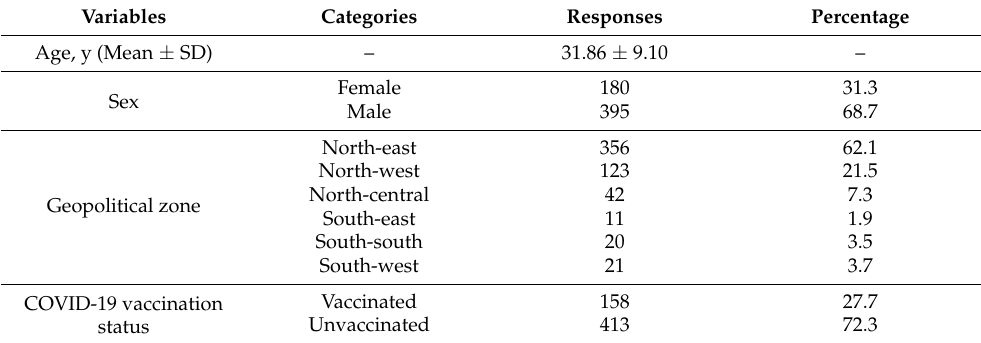
Table 1. Participant demographics and COVID-19 vaccination